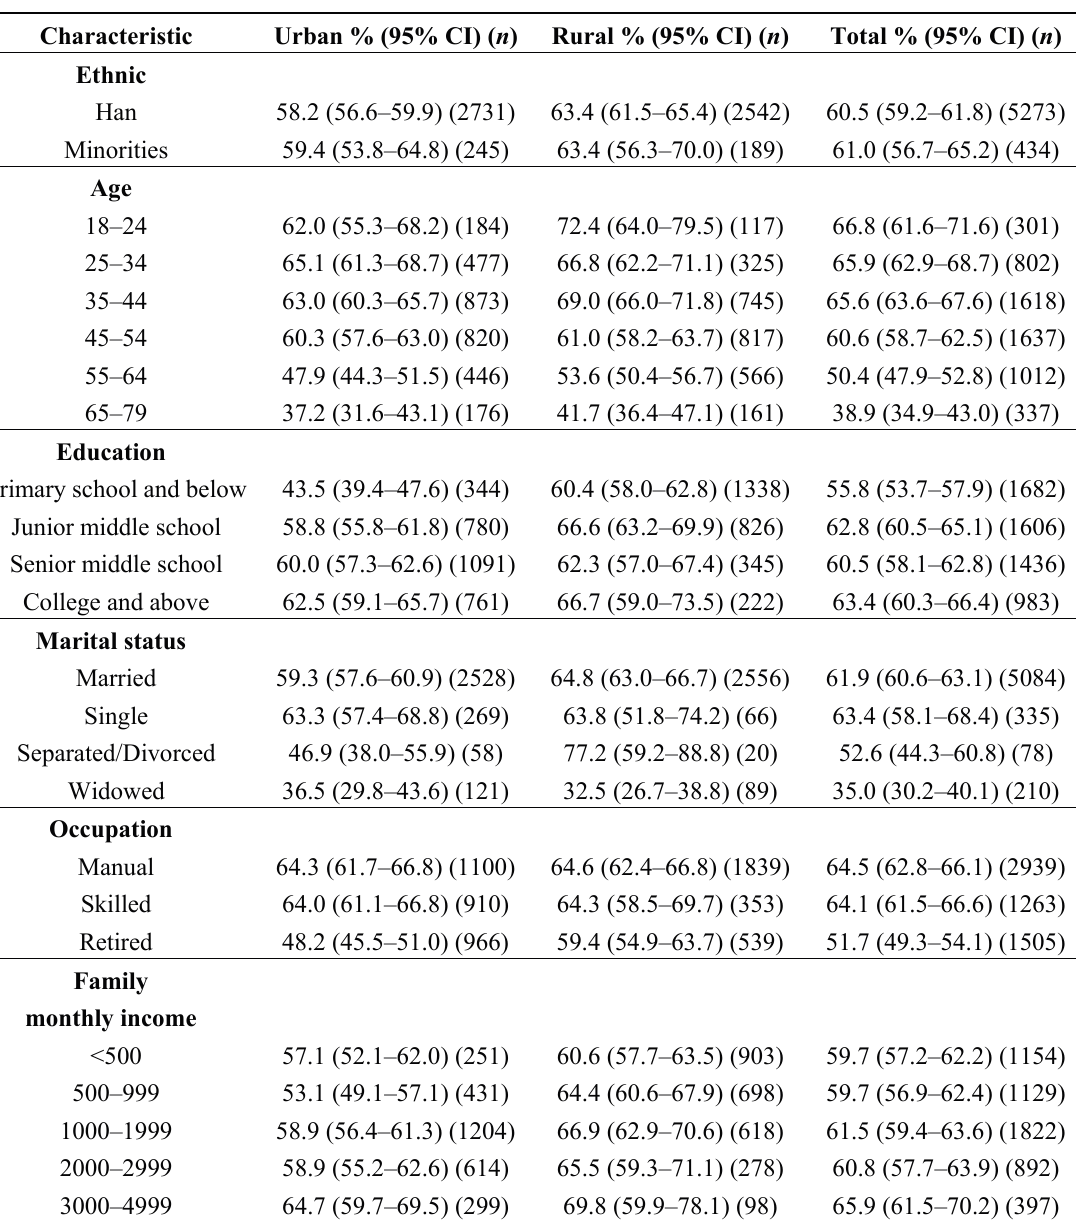
Table 3. Prevalence of passive smoking among non-smoking women aged 18 years or over by socio-demographic characteristics in Jilin Province,